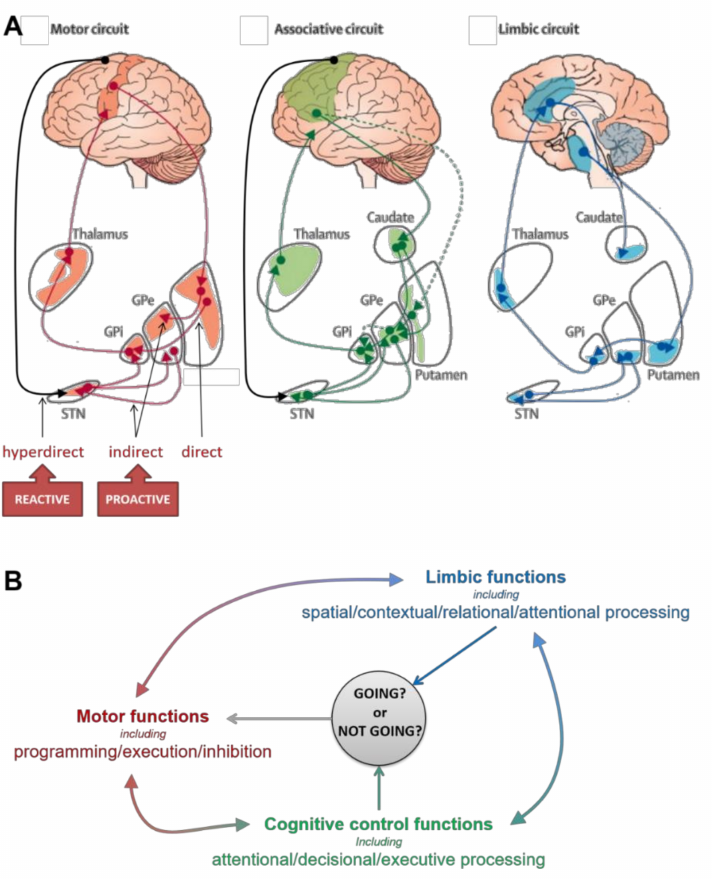
Figure 1. Main functional subdivisions of the cortico–striatal circuits ( A ) and associated functions ( B ) possibly involved in proactive and reactive inhibitory control. The striatum and the subthalamic nucleus (STN), the two input stations of the basal ganglia (BG) receive projections from a range of